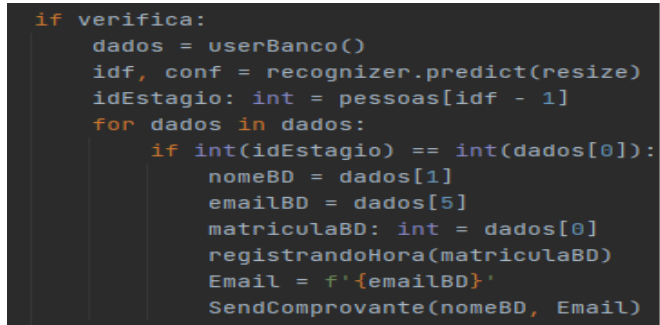
Figure 18: Trainee identification for time clocking